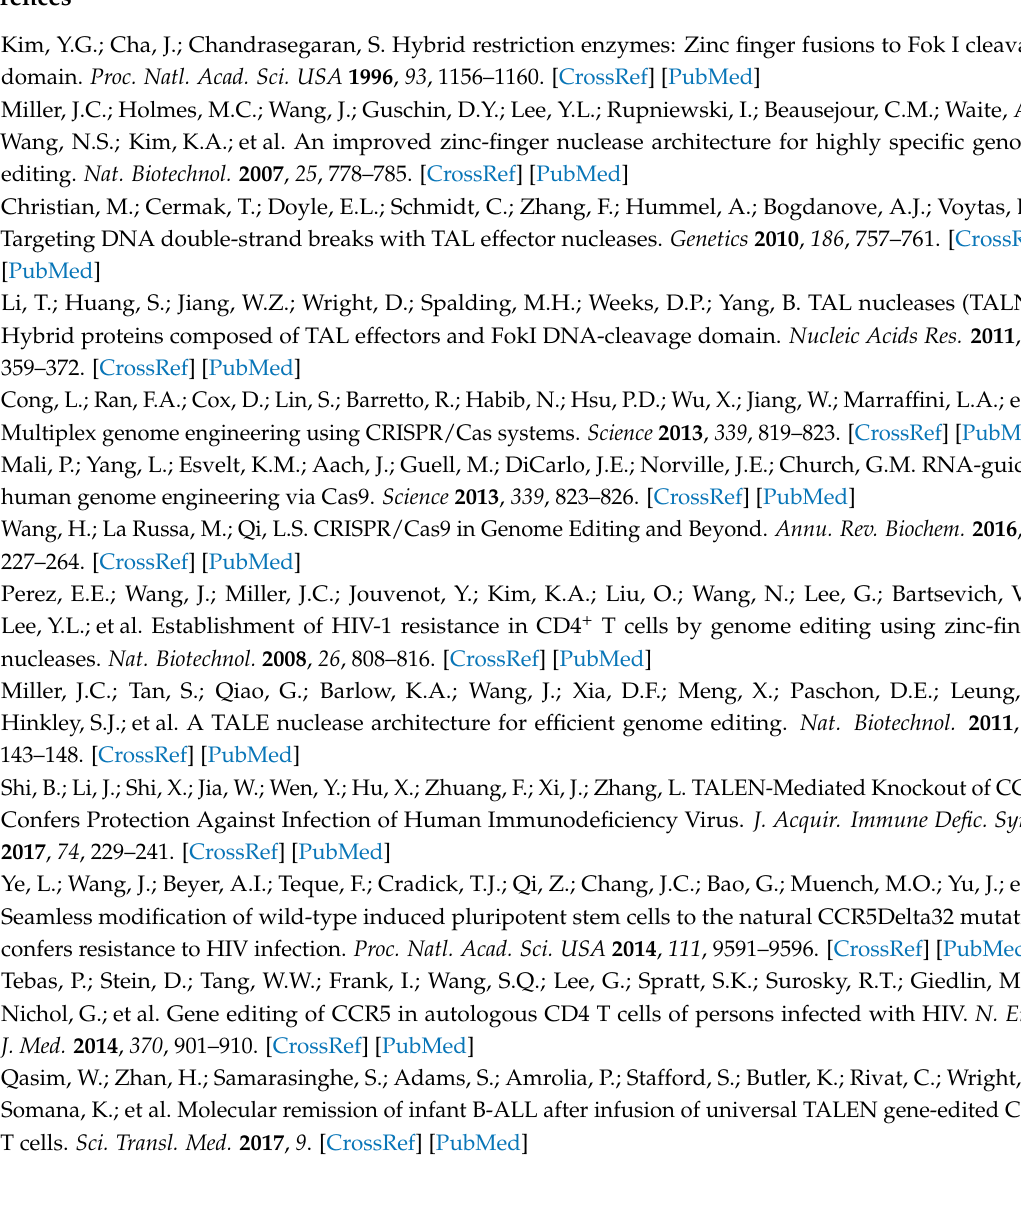
Figure S1: sequence of AAVS1-specific ZFN module, Figure S2: strategy to assemble ZFP coding DNA using overlapping PCR, Table S1: the list of primers used to change the specificity of ZFN, Table S2: primers for engineering pAAVS1- ∆ 8.2R donor plasmid, Table S3: primers for engineering pAAVS1-TagBFP donor plasmid, Table S4: primers for generating high fidelity Cas9, Table S5: sgRNA target sequences for double nicking, Table S6: DNA oligonucleotide sequences used for generation of GFP-turbo mutant and its reparation, Table S7: primers used to detect integration of HIV-1 ∆ Env (a) and Tag-BFP (b) transgenes into the human AAVS1